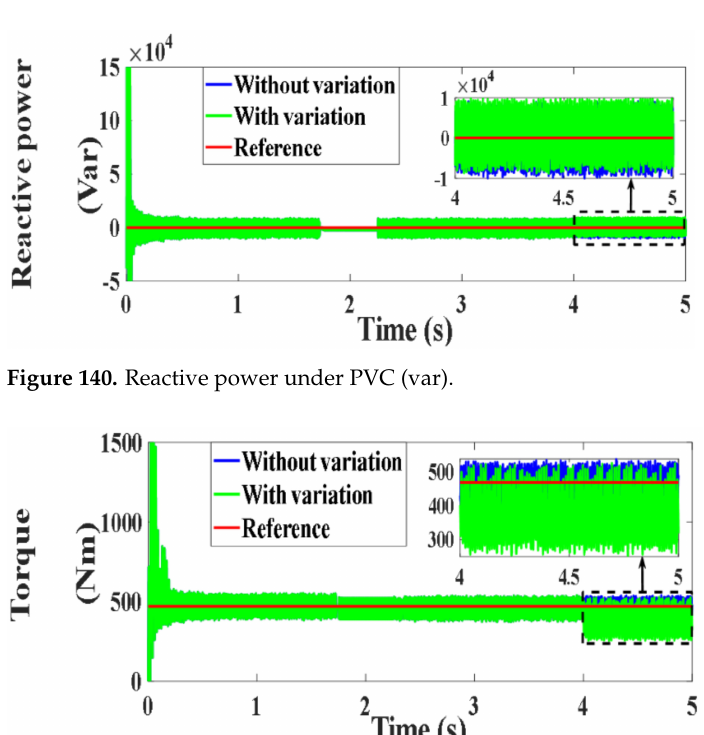
Figure 139. Active power under PVC (Watt).